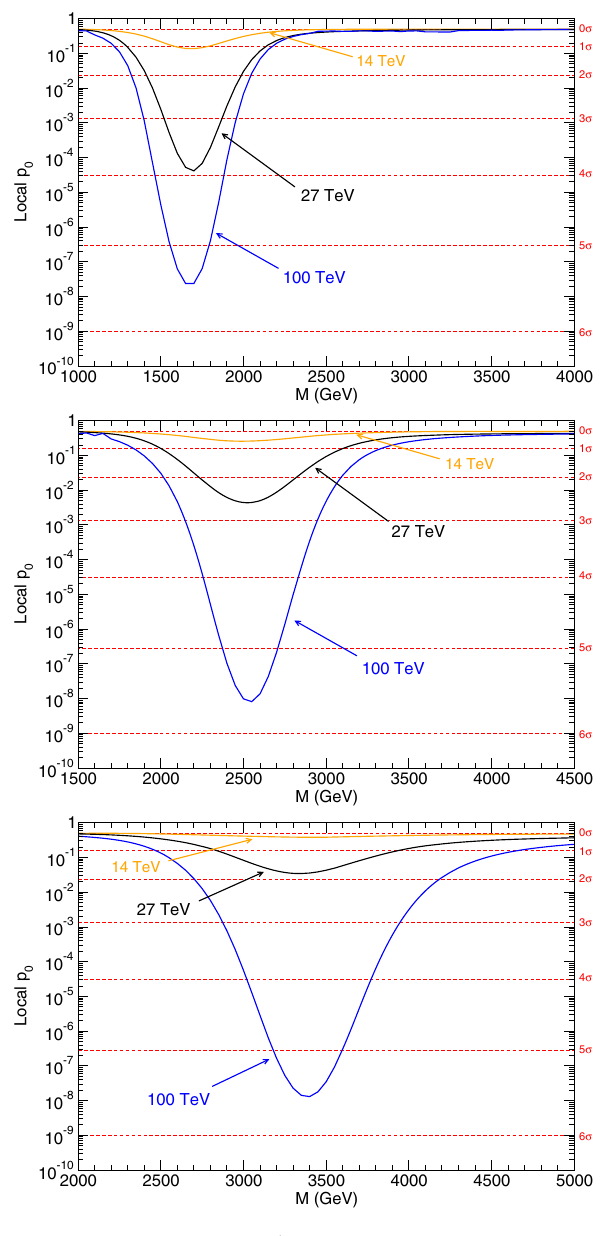
Fig. 11 Local p -valueofthe W (cid:2) signalsfor M W (cid:2) = 2TeV(top),3TeV (middle) and 4 TeV (bottom), at the three collider energies considered. The W (cid:2) couplings for each mass benchmark are given in the text